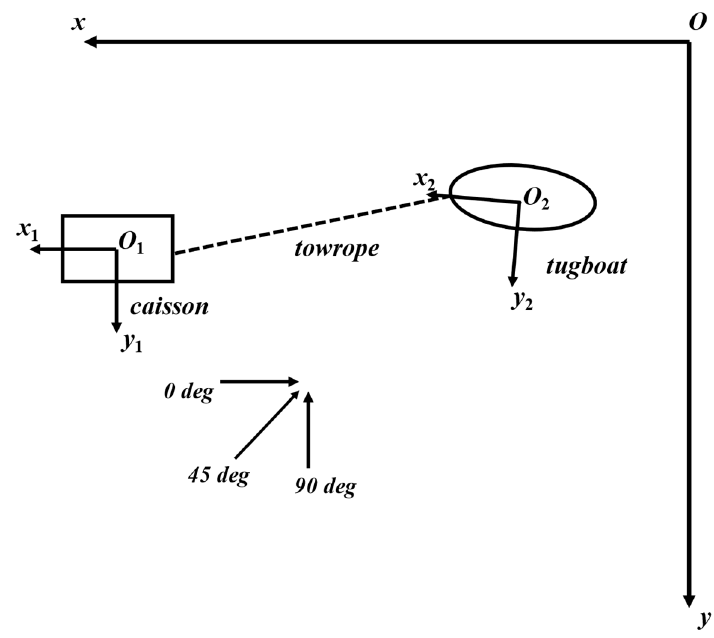
Figure 2. Coordinate systems applied in the research.